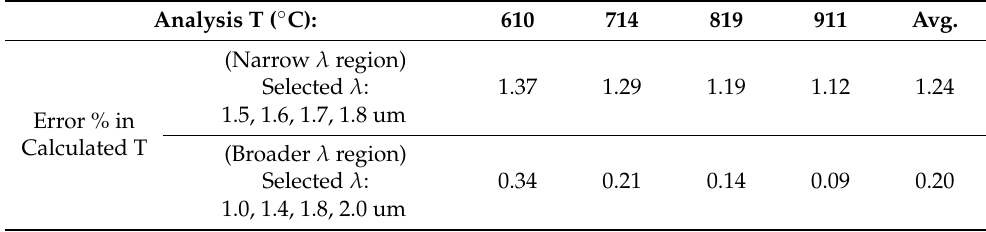
Table 3. Error in calculated temperature (T) from NLLS MRT analysis using (a) narrow and (b) broader distribution of the four measurement